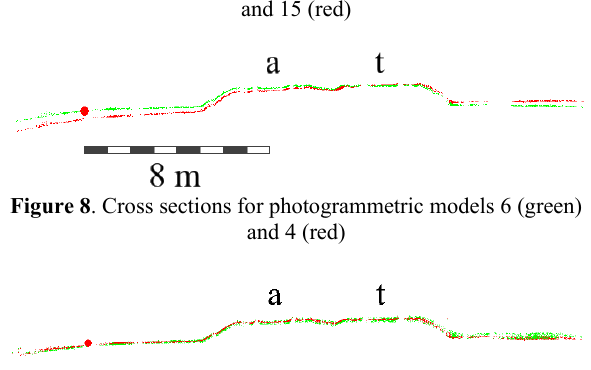
Figure 7. Cross sections for photogrammetric models 6 (green)